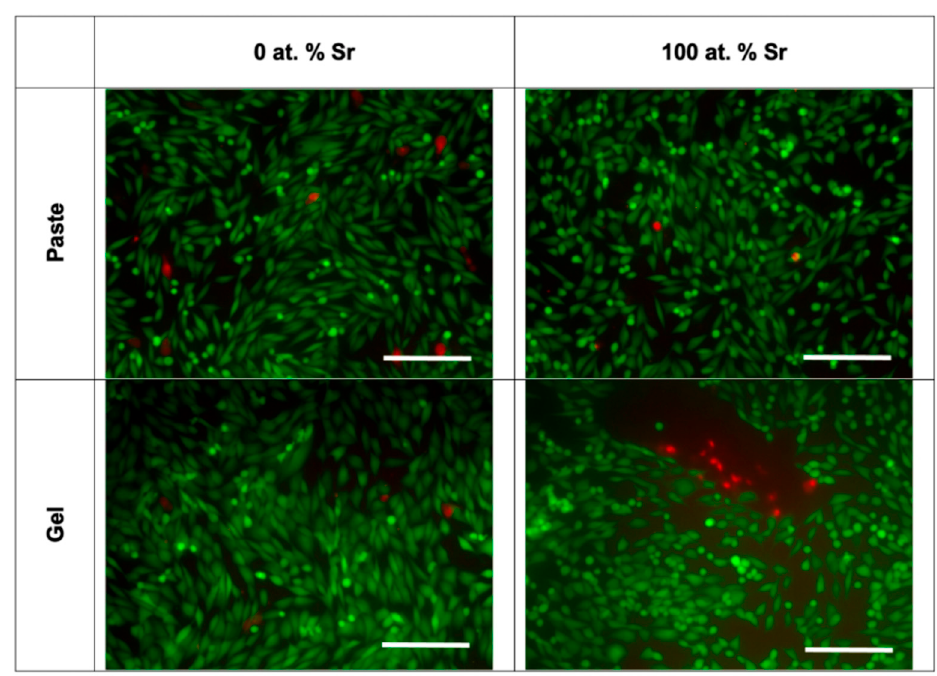
Figure 10. Live/dead fluorescence imaging for MG63 cells cultured indirectly with SrHA paste and gel (0 and 100 at.% Sr). Scale bar = 200 µm.